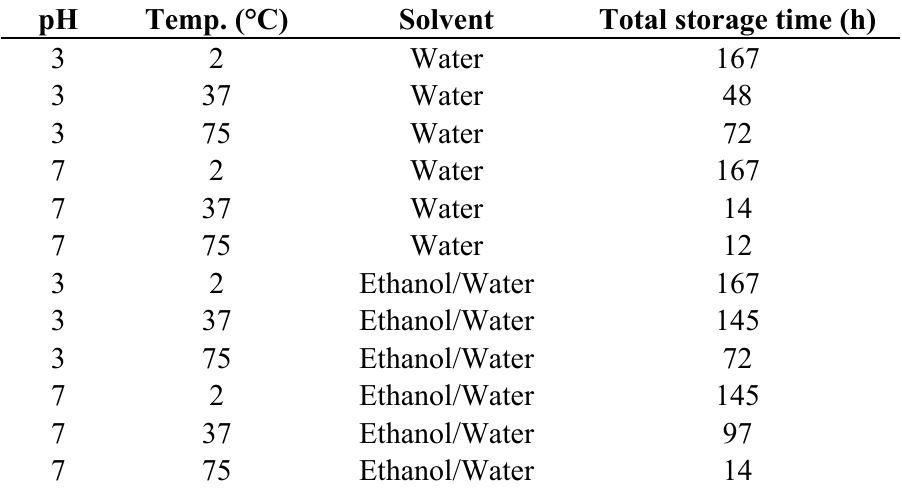
Table 3. Total storage times of anthocyanins from cranberrybush fruits extracts in different conditions. pH Temp. (°C) Solvent Total storage time